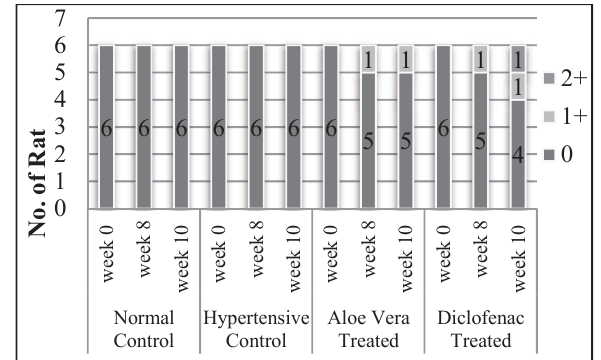
Fig-5: Effect of Aloe vera gel and diclofenac on urinary proteins of hypertensive rats (n=6)